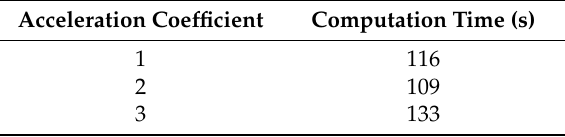
Figure 10. Convergence with different acceleration coefficients. Table 3. Computation time with different acceleration coefficients.